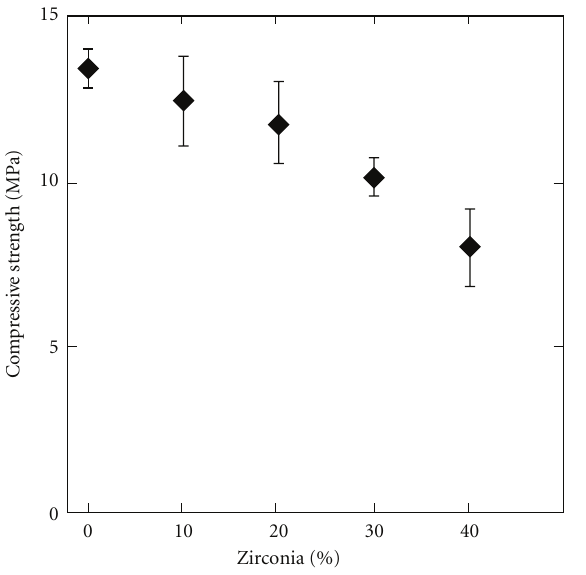
Figure 2: Diagram showing the influence of ZrO 2 content (0 to 40%) on setting time of the pCPC. Error bars represent standard deviation, n = 3.